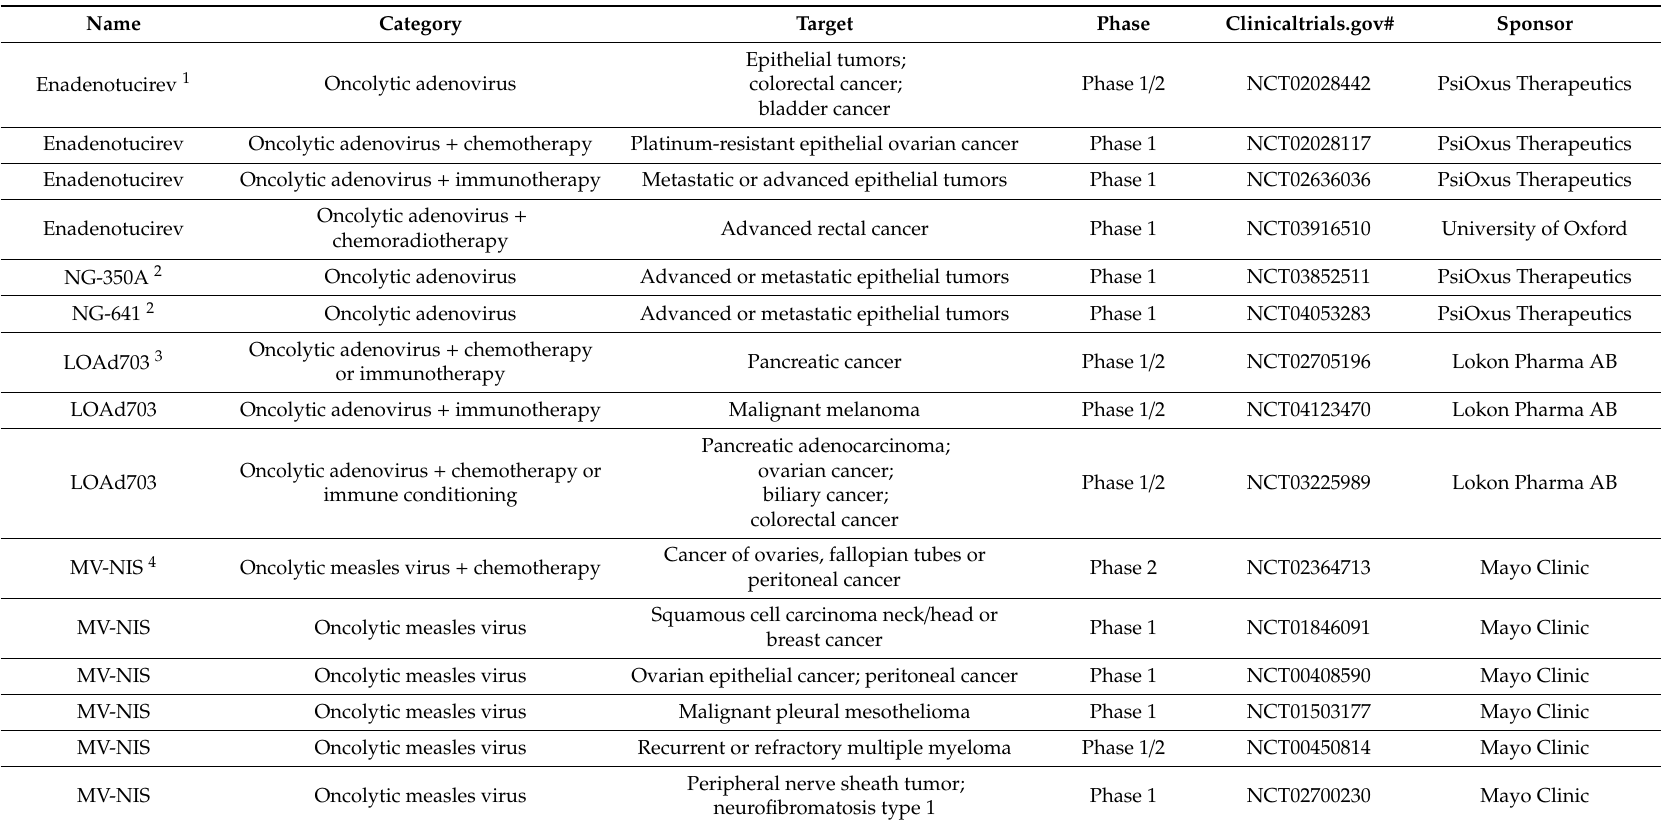
Table 1. Clinical trials of CD46-based cancer